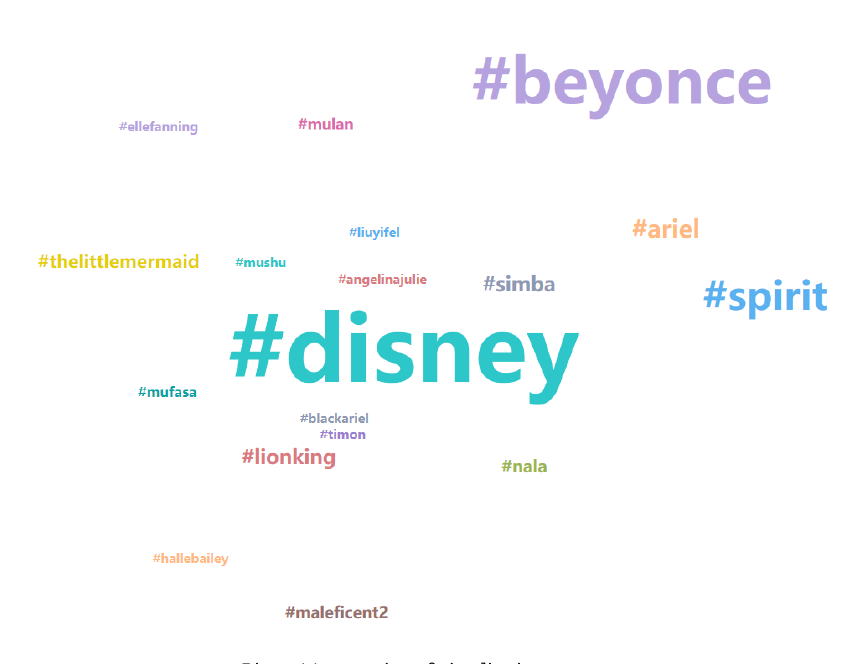
Figure 14 event view of visualization